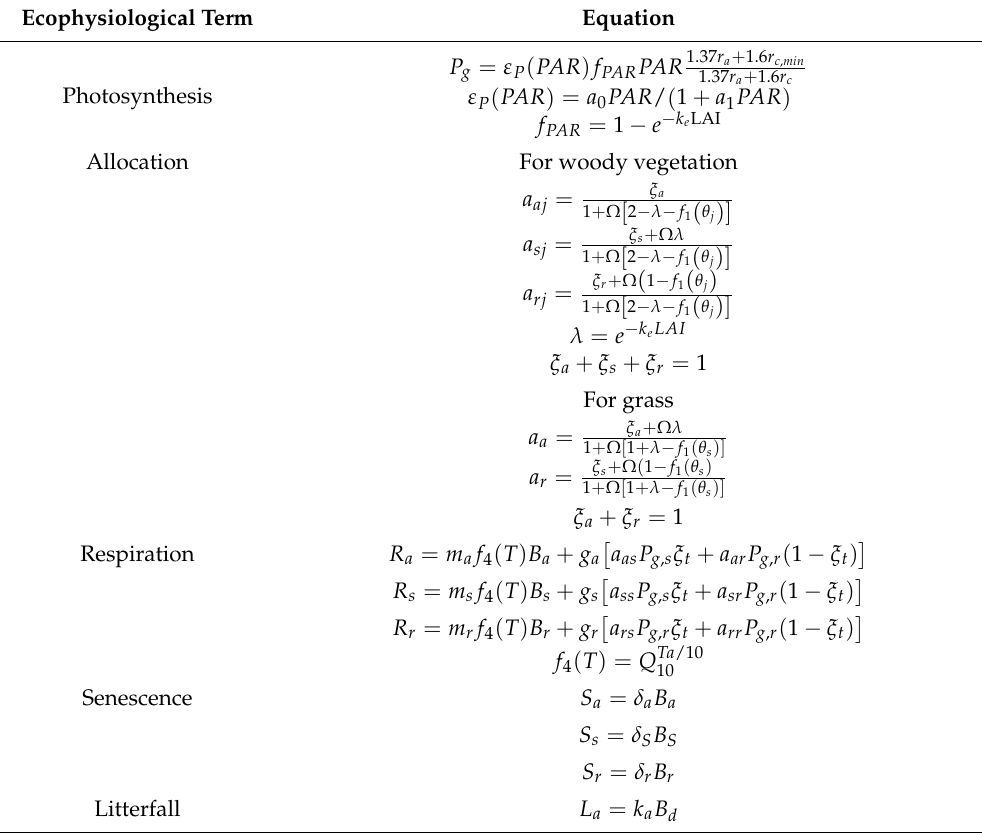
Table 2. Equations of the vegetation dynamic model components. Parameters are defined in Table